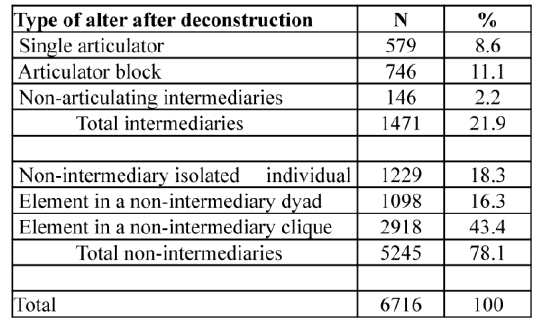
Table 1. Distribution of types of alters after de-